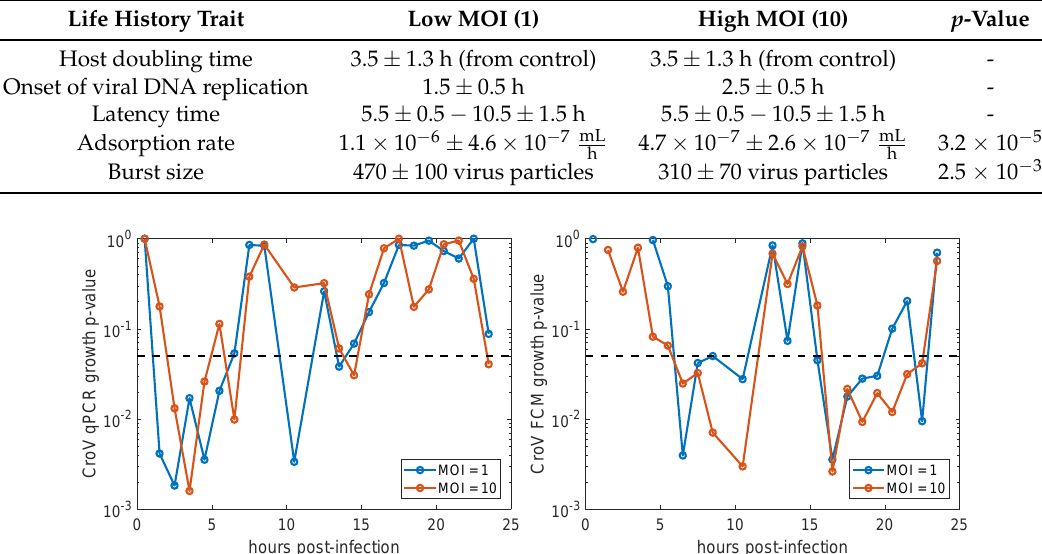
Table 1. Life history traits of CroV and its host. We calculated p -values for parameters with multiple values across each MOI using t -tests.